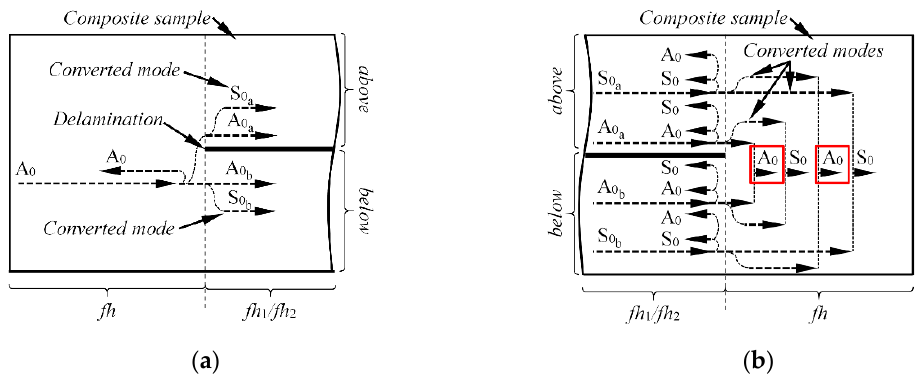
Figure 3. Graphic representation of A 0 mode interaction with delamination ‐ type defect at the leading ( a ) and trailing edge ( b ).